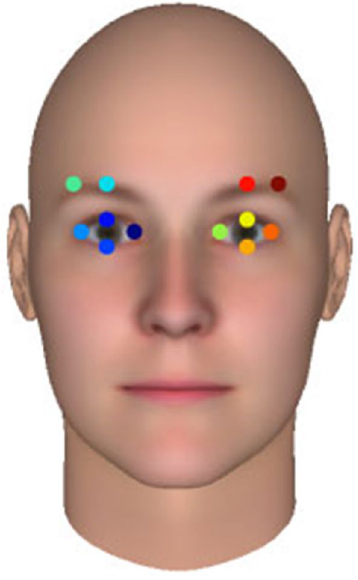
Figure 1. The annotated points of facial expression that this study focused on: upper and right (left) sides of the eyebrow, right (and left) outer corners of the eye, inner corners of the eye, and top and bottom of the